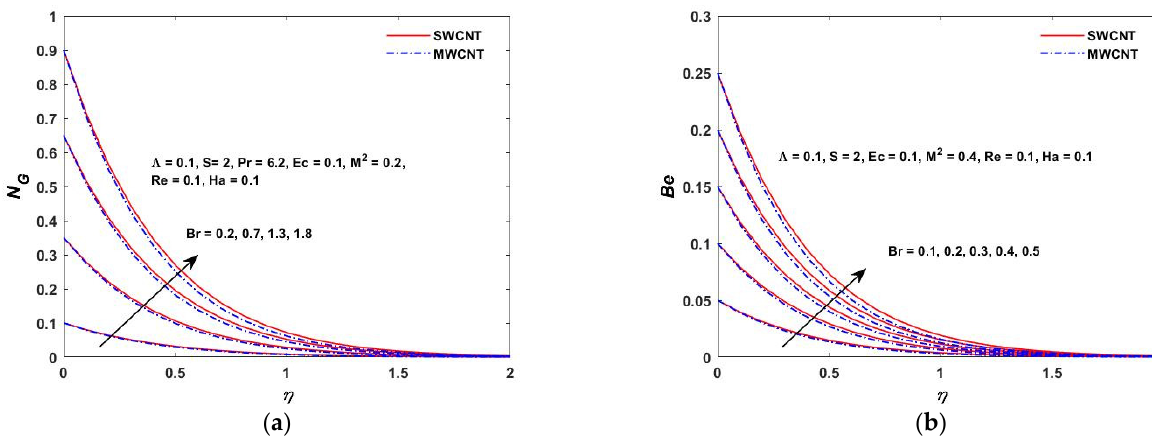
Λ verses Bejan (Be). G . ( b )